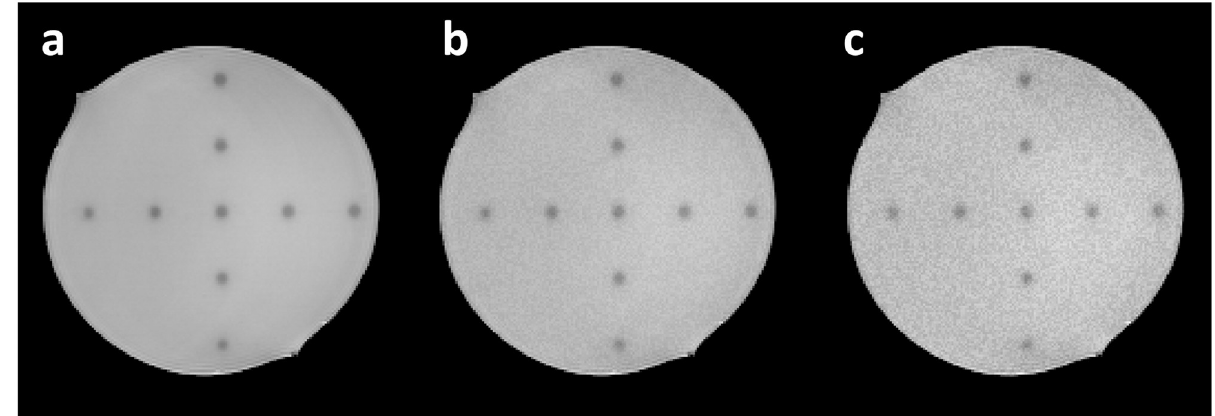
Fig 1. MRIs of the irradiated phantom. (a) An indicative axial image of the irradiated phantom, depicting the polymerized areas (lower T2-weighted signal) as a result of GK 4-mm shot delivery. (b) and (c) The same slice after applying 5% and 10% random noise, respectively, for estimating control point localization